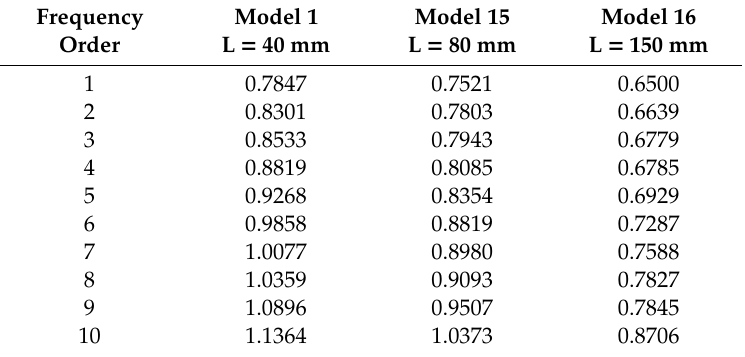
Table 8. Natural frequencies (Hz) of Mode 1, 15, and